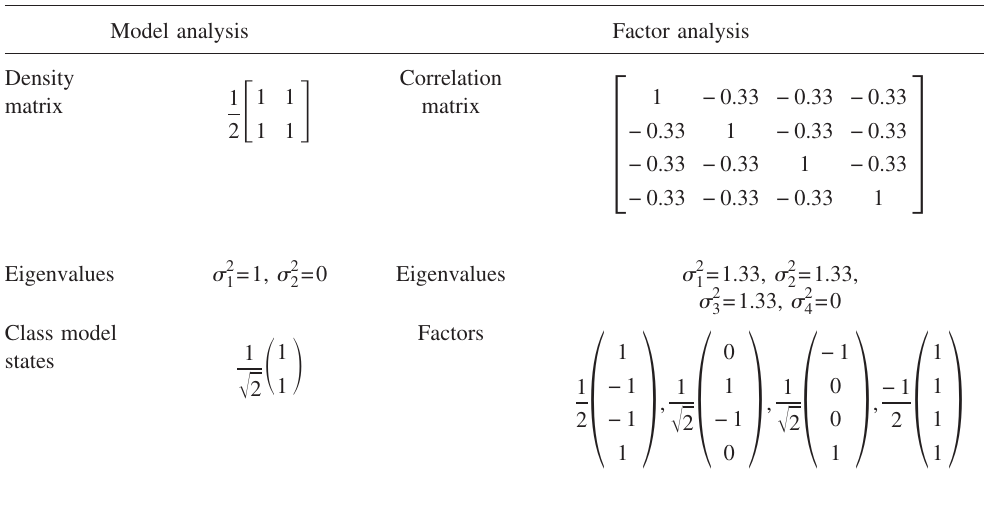
TABLE III. Results from model analysis and factor analysis for a class having two equal populations each with a consistent model. Model analysis